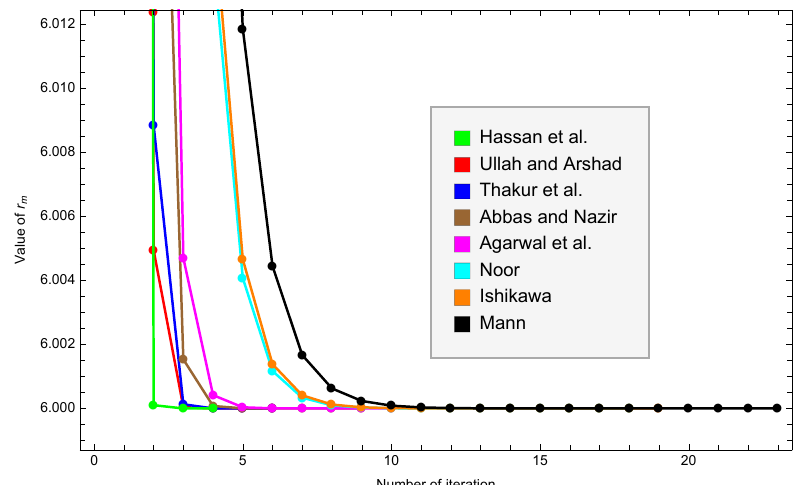
Figure 1. Behaviors of different iterative procedures in the class of RSTN mappings using T in Example